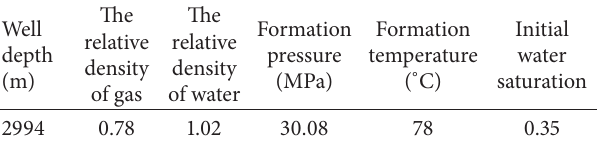
Table 1: The basic parameters of an actual well.